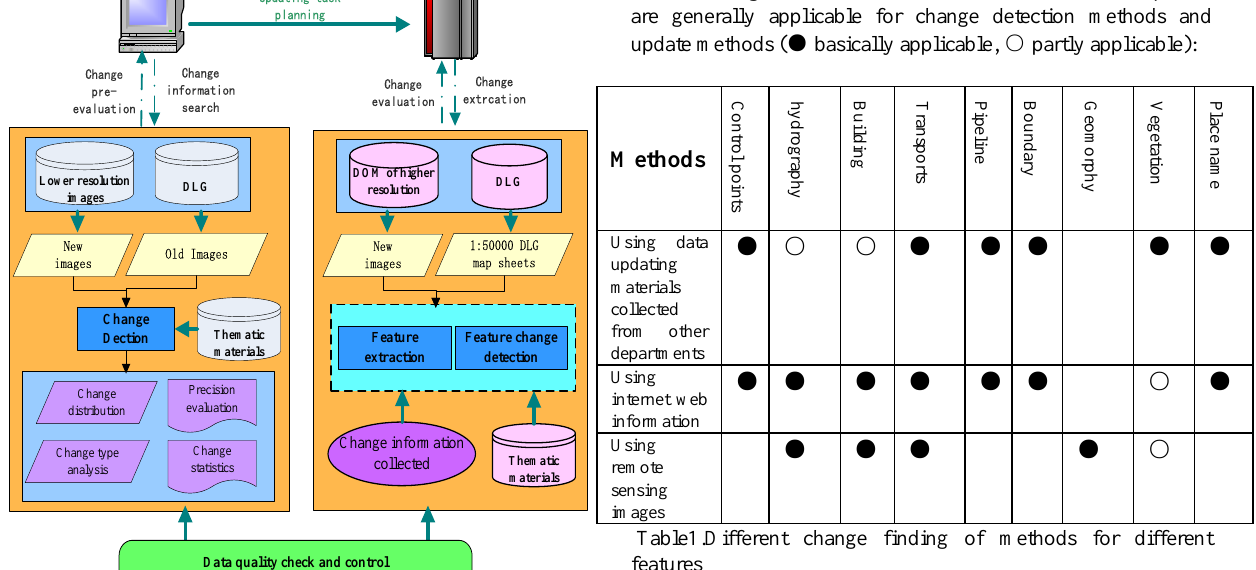
Table1.Different change finding of methods for different